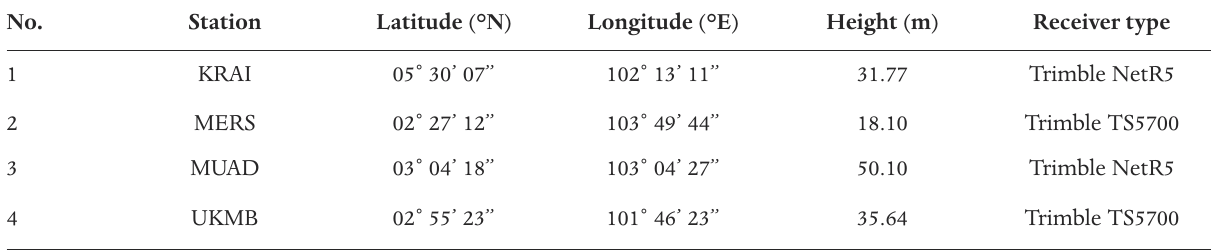
Table 1. GPS Coordinates for KRAI, MERS, MUAD and UKMB stations.